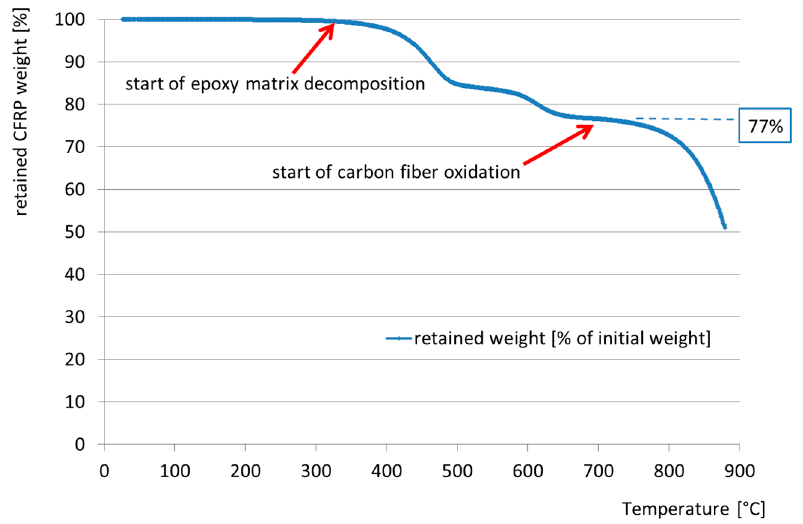
Figure 7. Thermogravimetric (TGA) plot (mass loss vs. temperature) for the UHM CFRP material.